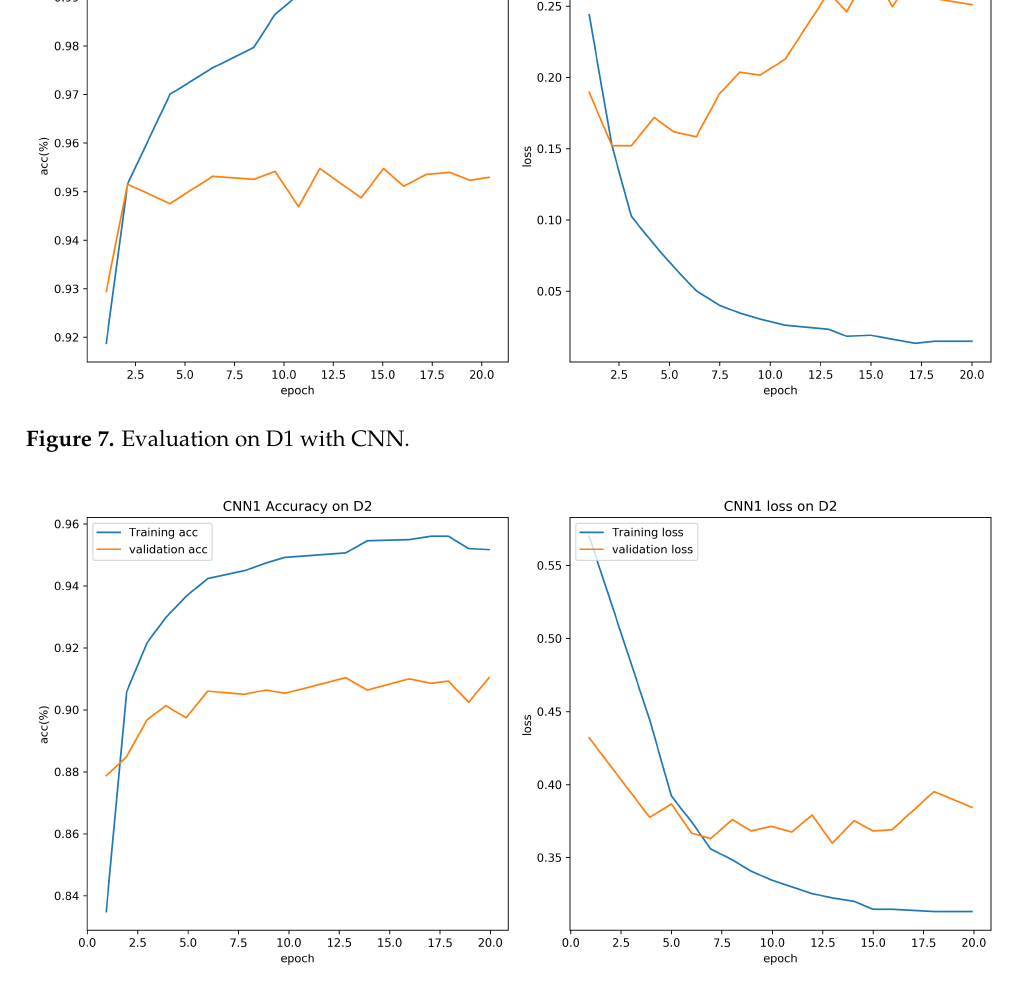
Figure 8. Evaluation on D1 with